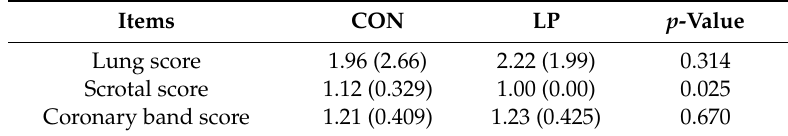
Table 6. The e ff ects of high protein (CON) and low protein (LP) diets on lung, scrotal and coronary band scores.